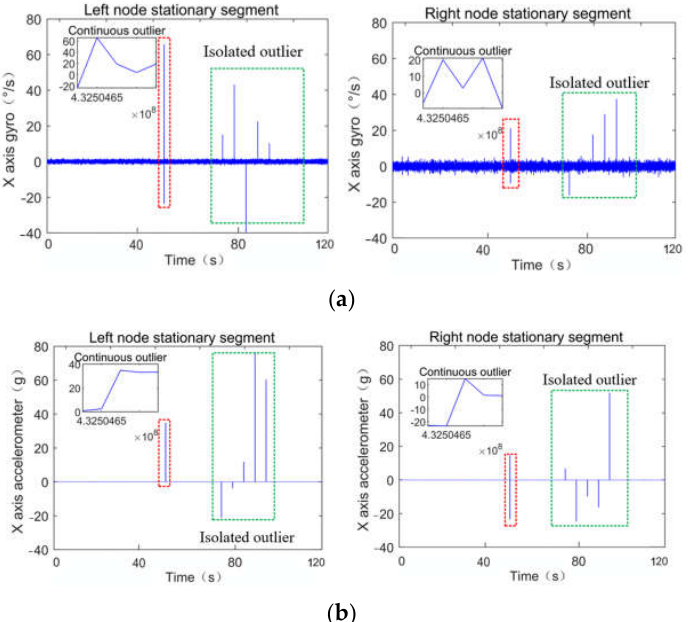
Figure 8. Data from the IMU after adding outliers. ( a ) Data from the gyro in the x-axis direction after adding outliers; ( b ) data from the accelerometer in the x-axis direction after adding outliers.